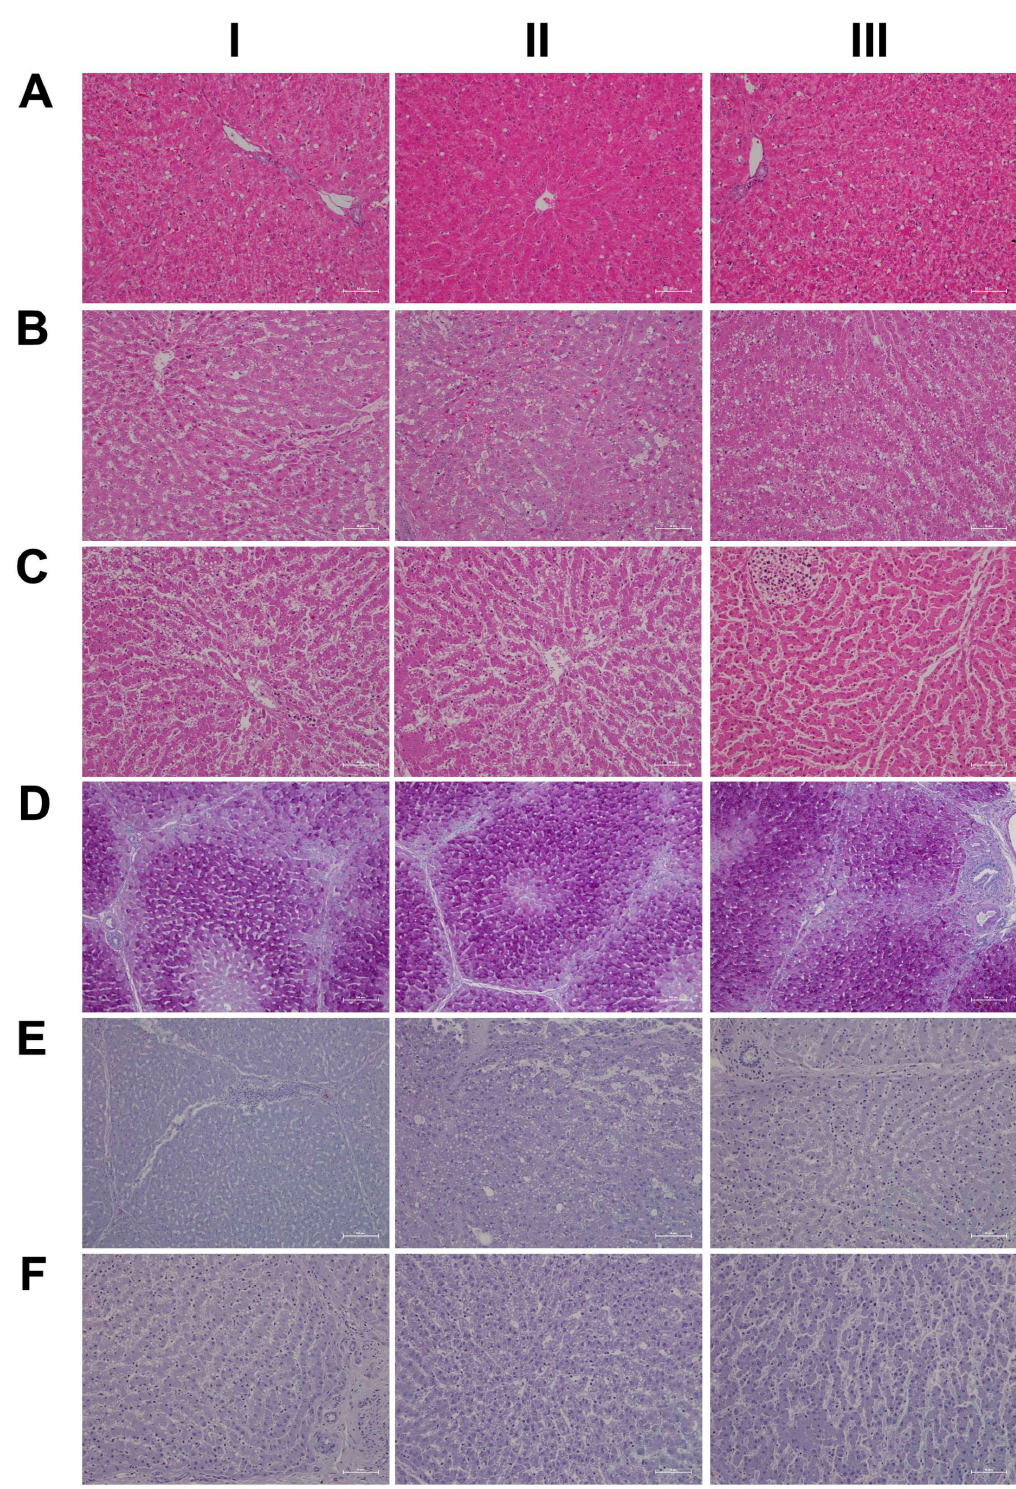
Figure 1. Liver HE and PAS staining of control and diclofenac-treated animals after daily dosing for 28 days. Panel AI–III: HE staining of three individual control animals with normal morphology of